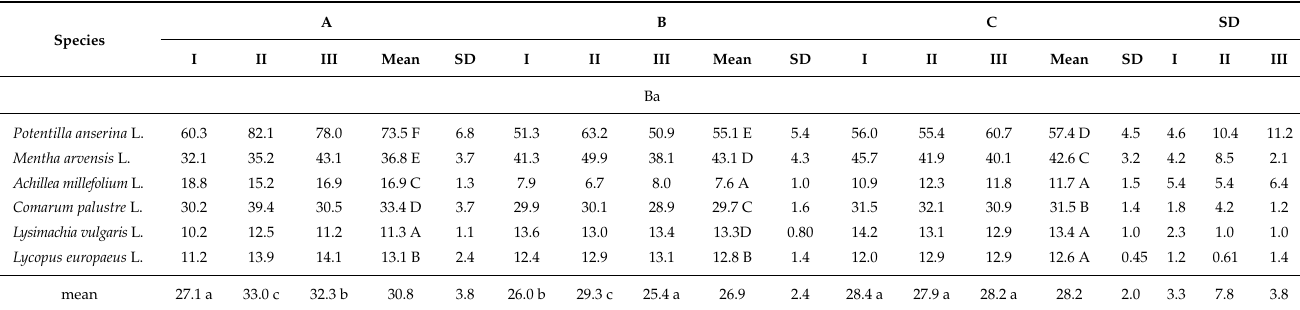
Table 1. Ba concentration (mg kg − 1 ) in the biomass of some